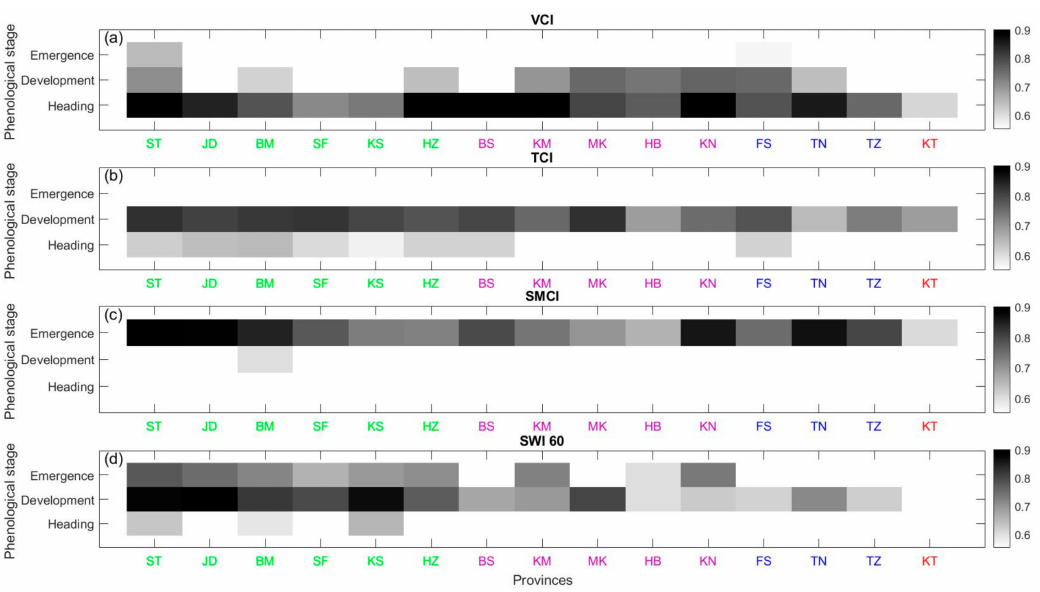
Figure 8. Correlation between VCI ( a ), TCI ( b ), SMCI ( c ), SWI60 ( d ) and cereal yield for key